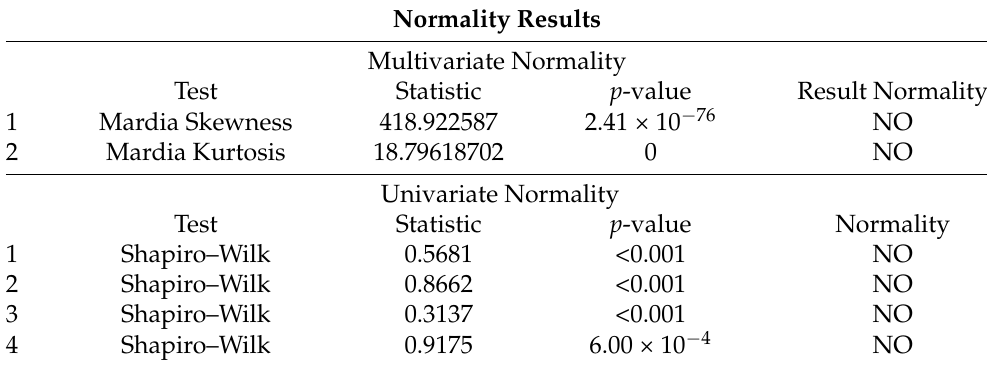
Table 4. Multivariate normality test.